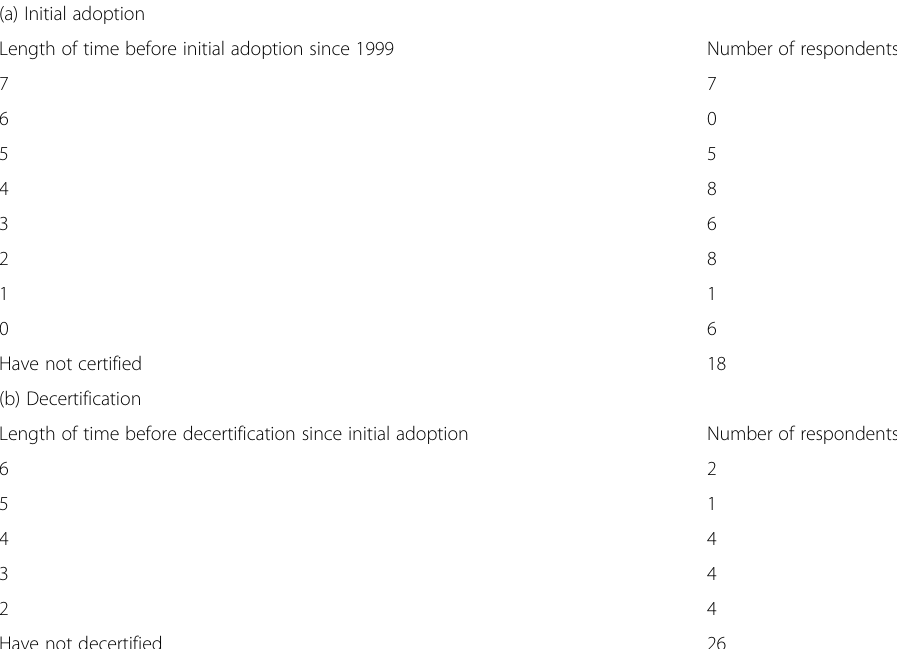
Table 3 Distribution of respondents based on year of initial adoption (a) and length of time before decertification (b) (reference is